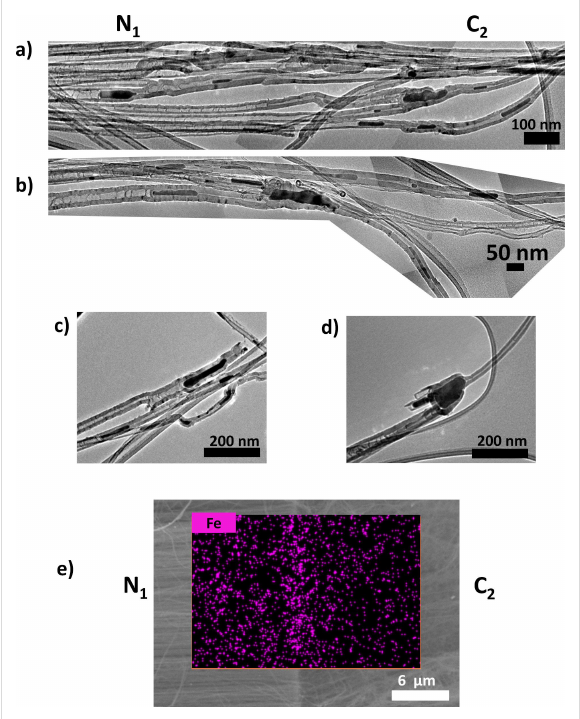
Figure 4: (a–d) TEM characterization of a N 1 /C 2 interface marked by the presence of metal (iron) nanoparticles before and after a clear change in the typical structure of N (larger inner diameter and corru- gated structure) and C (smaller inner diameter) sections. Panels (a,d) were obtained by superimposing several TEM micrographs, all taken at the same magnification along the N 1 /C 2 interface. (c,d) Examples of individual MWCNTs with a clear change of structure before and after the interface, which is marked by a nanoparticle (dark structure in the TEM images). (c) Broken MWCNT structure after the interface, where- as in (d) the structure remains intact. (e) SEM backscattered images and the related Fe EDS mapping at a N 1 /C 2